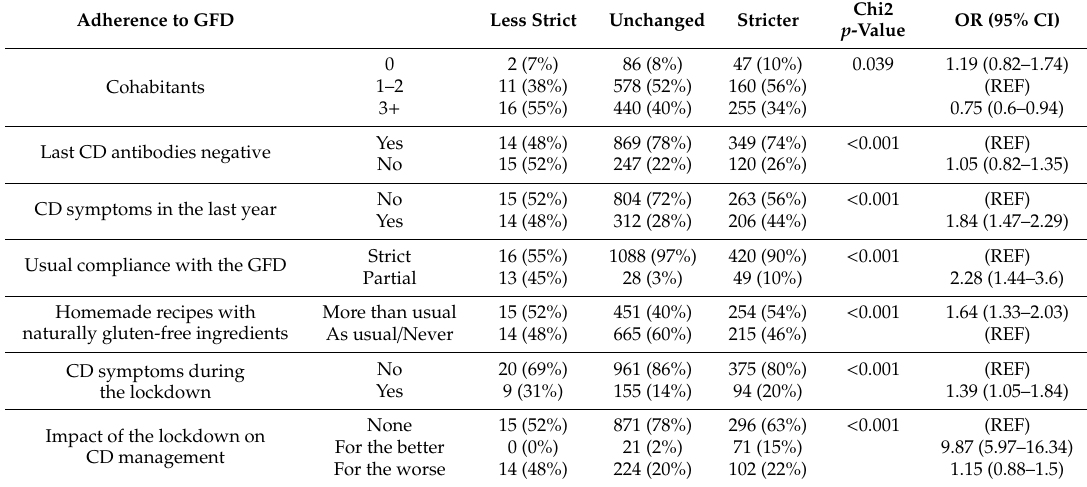
Table 5. Factors influencing the adherence to GFD during the lockdown, as reported by adults with CD.